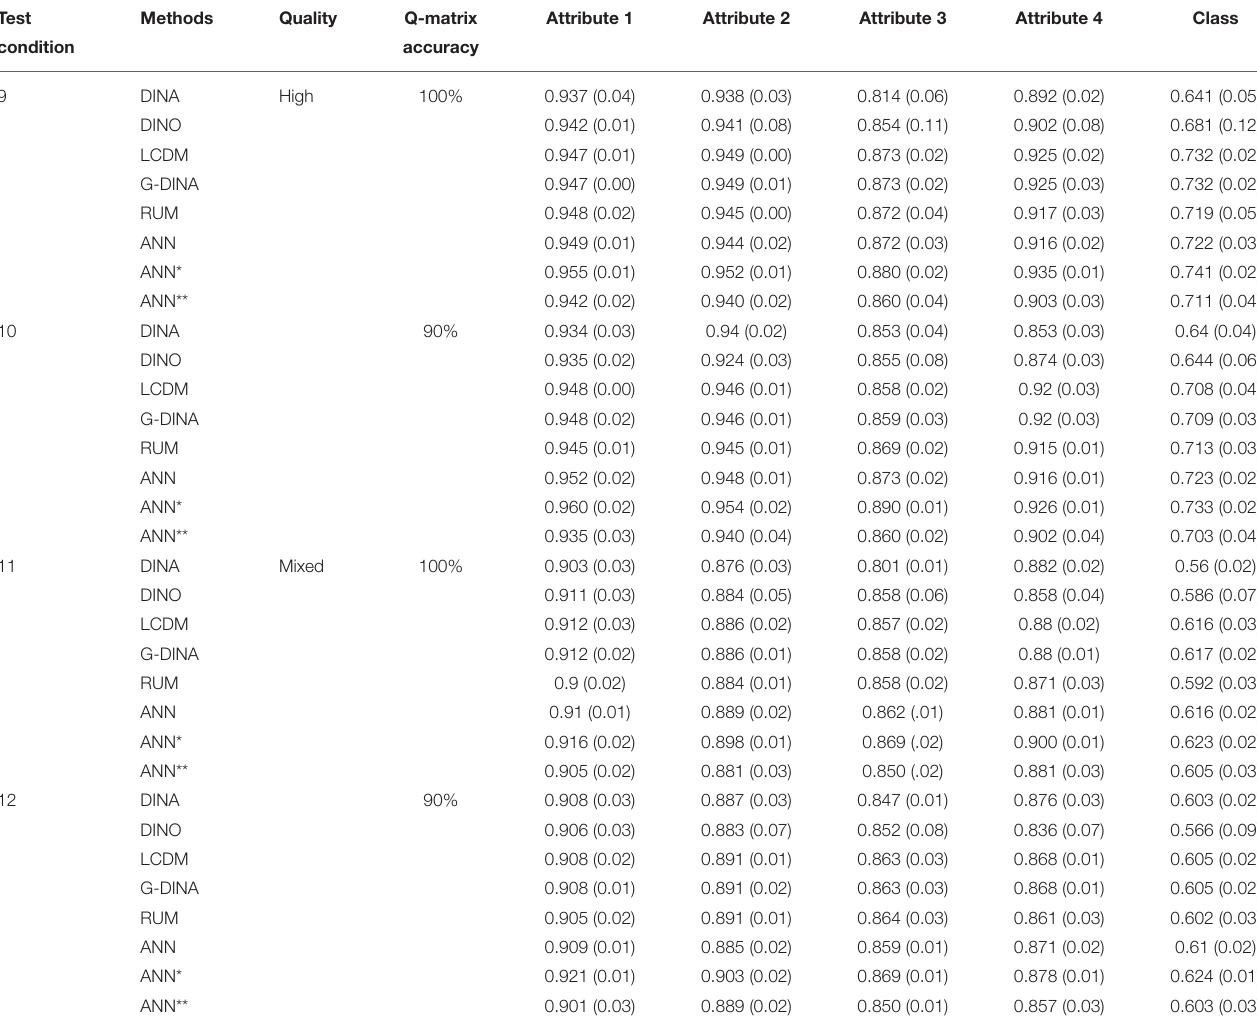
TABLE 4 | Comparison of classification rates for 4 attributes using 30